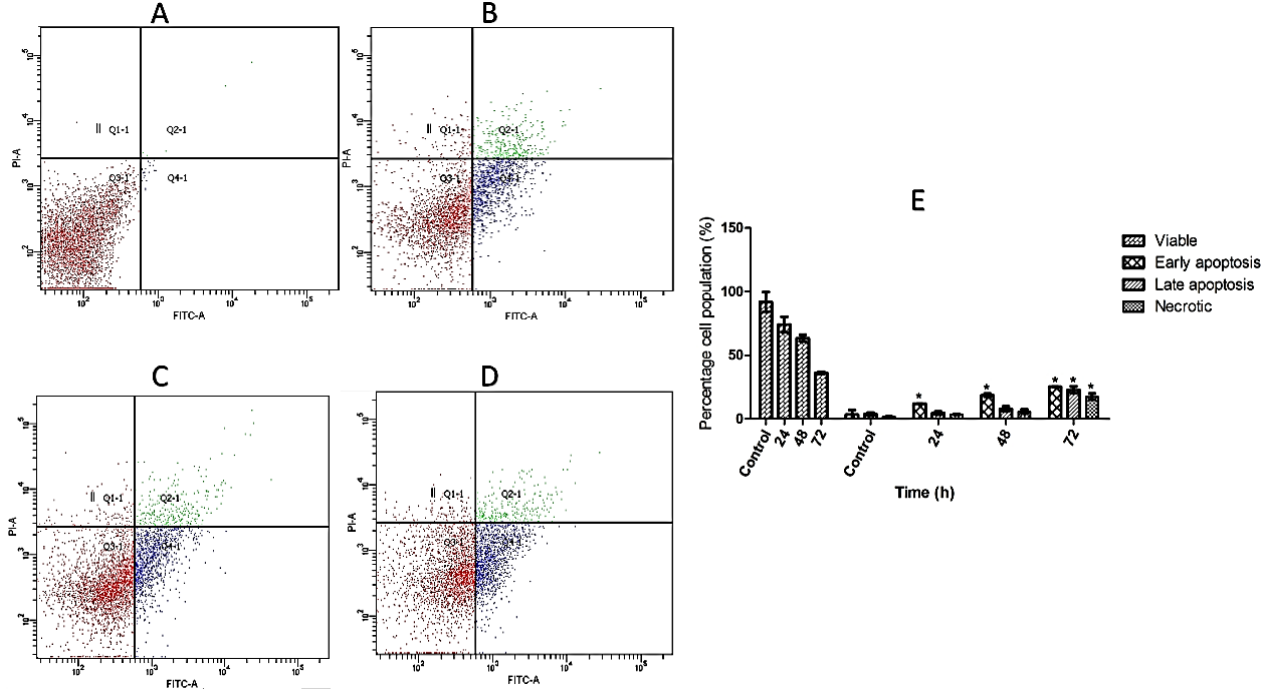
Figure 5. Time-dependent induction of early and late apoptosis by TPHE after ( B ) 24, ( C ) 48 and ( D ) 72 h of treatment. ( A ) represents the untreated cells as the control. ( E ) Representative bar chart depicted the percentage of early apoptotic, late apoptotic and necrotic cells. The data are shown as the mean ± SD ( n = 3). * represents significant difference ( p < 0.05) compared with the